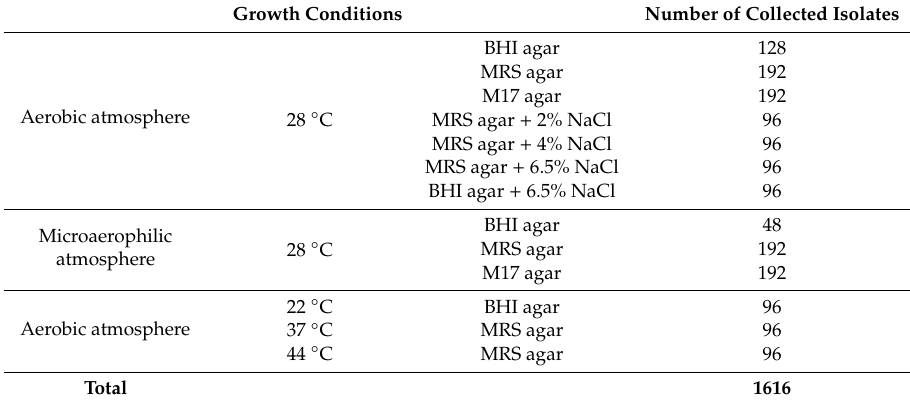
Table 5. Growth conditions and number of collected isolates used to build the bacterial library. Growth Conditions Number of Collected